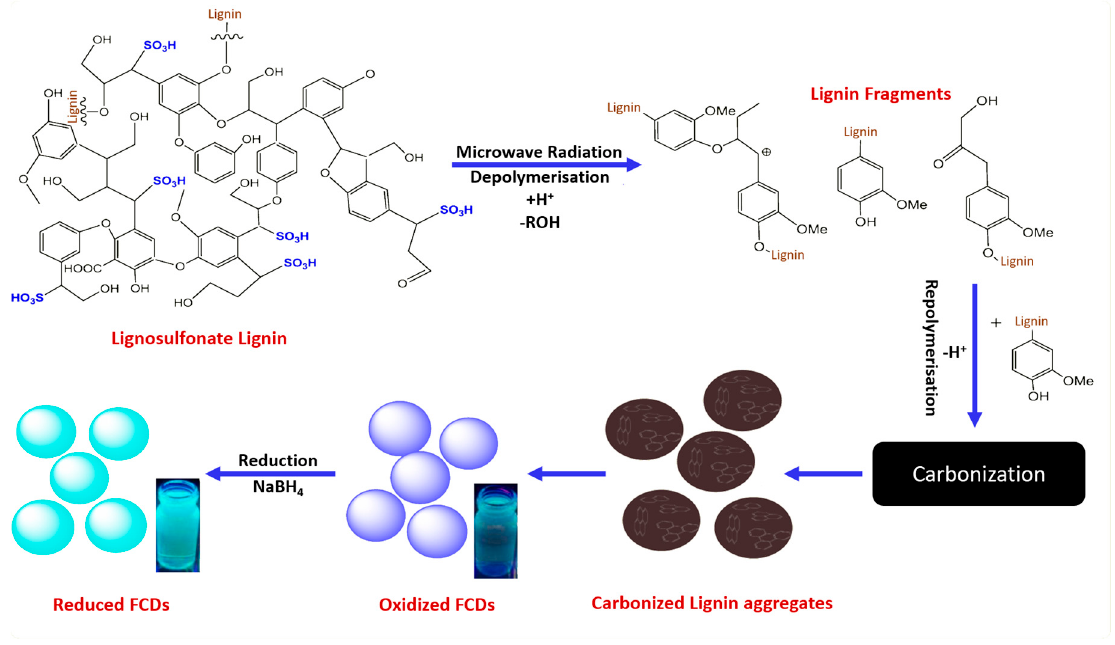
Figure 8. Schematic representation of the production procedure for reduced fluorescence carbon dots from lignosulfonate lignin in aqueous acidic media, including possible depolymerisation and formation reaction mechanisms in which sulfonate groups were neglected. Reprinted from [107], with permission from Elsevier.